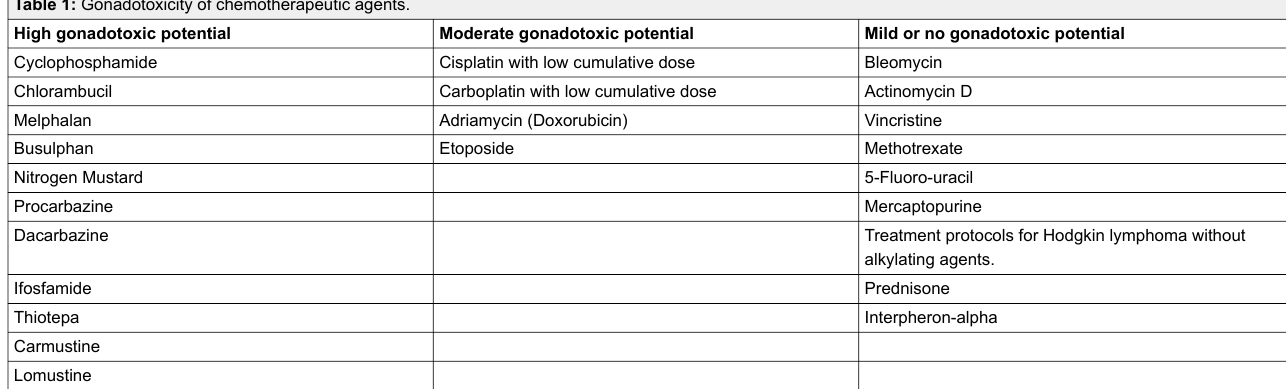
Table 1: Gonadotoxicity of chemotherapeutic agents. High gonadotoxic